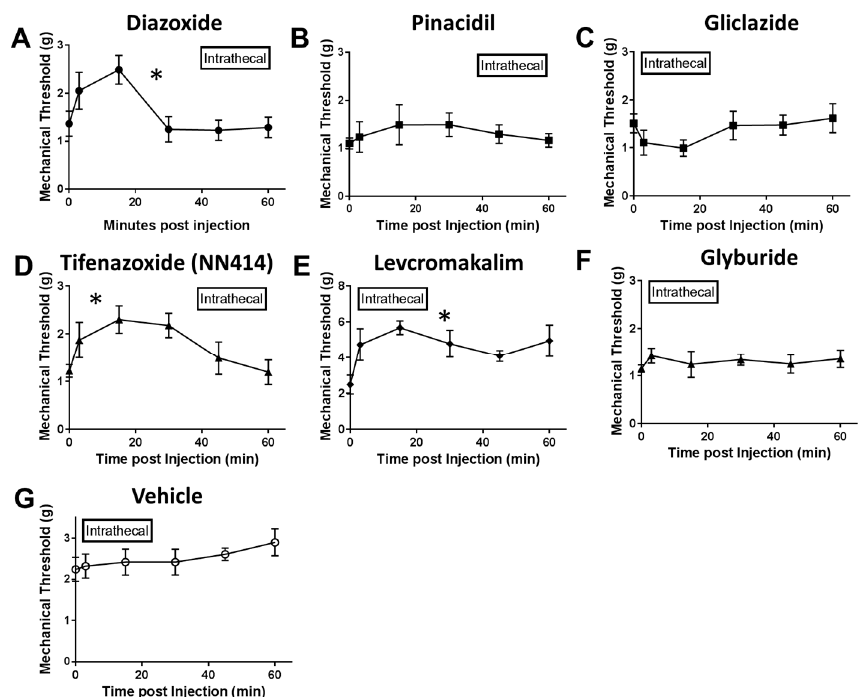
Figure 6. Paw withdrawal thresholds and latencies are increased after intrathecal administration of SUR1 agonists. Administration of the SUR1 agonist diazoxide ( A ), the Kir6.2 / SUR1 agonist NN-414 ( D ) or the Kir6.2 / SUR2 agonist levcromakalim ( E ) significantly increased paw withdrawal thresholds compared to vehicle ( G ) (10 µ L, hindpaw; * p < 0.05, repeated measures ANOVA, F (6, 56) = 32.94, * * p < 0.05, CI diazoxide = − 0.7470 to − 0.4126, CI NN414 = − 0.999 to − 0.1607, CI levcromakalim = − 3.363 to − 1.969). Error bars: SEM; n = 5–10/group.